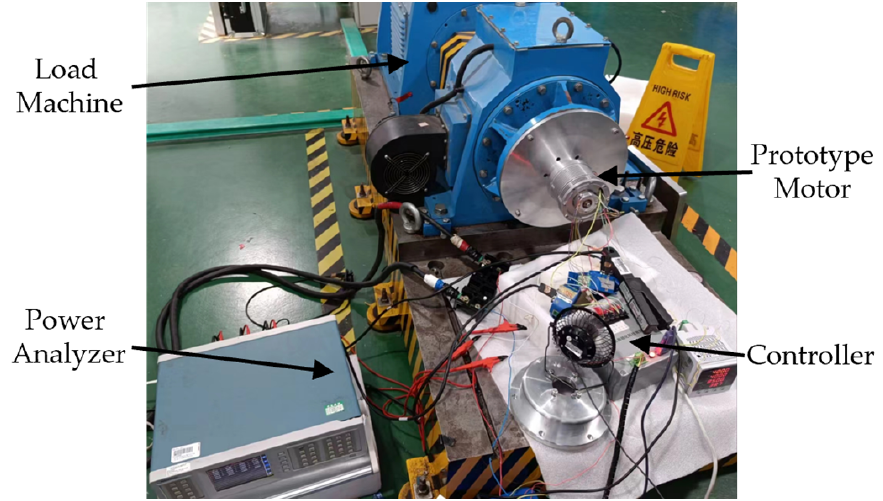
Figure 13. The experimental platform of ultimate torque test. Table 6. The measurement results of load torque.